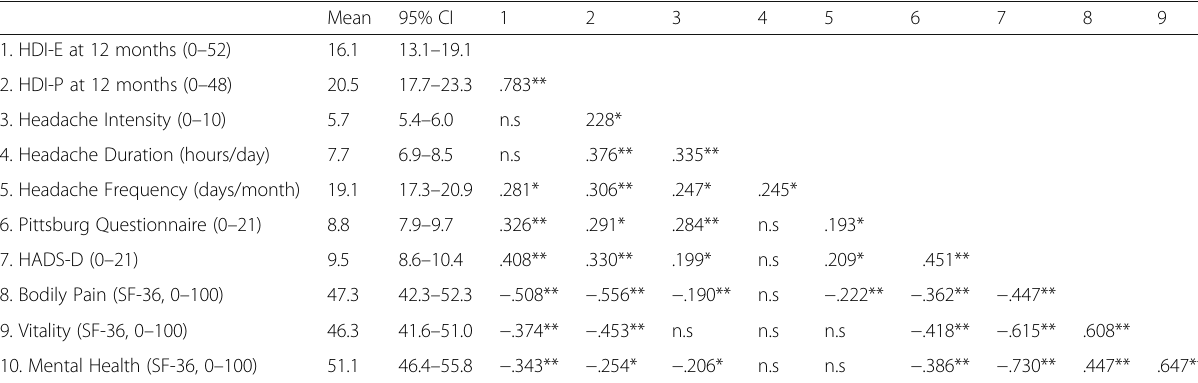
Table 1 Pearson-Product Moment Correlation Matrix for Functional and Psychological Variables at Baseline Statistically Associated with the Physical or Emotional Burden of Headache at One Year Mean